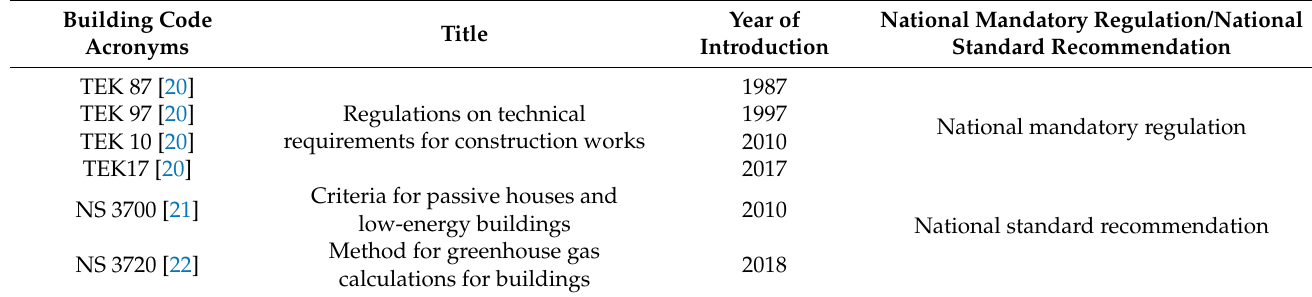
Table 1. The Norwegian building regulations and standards used in the study.